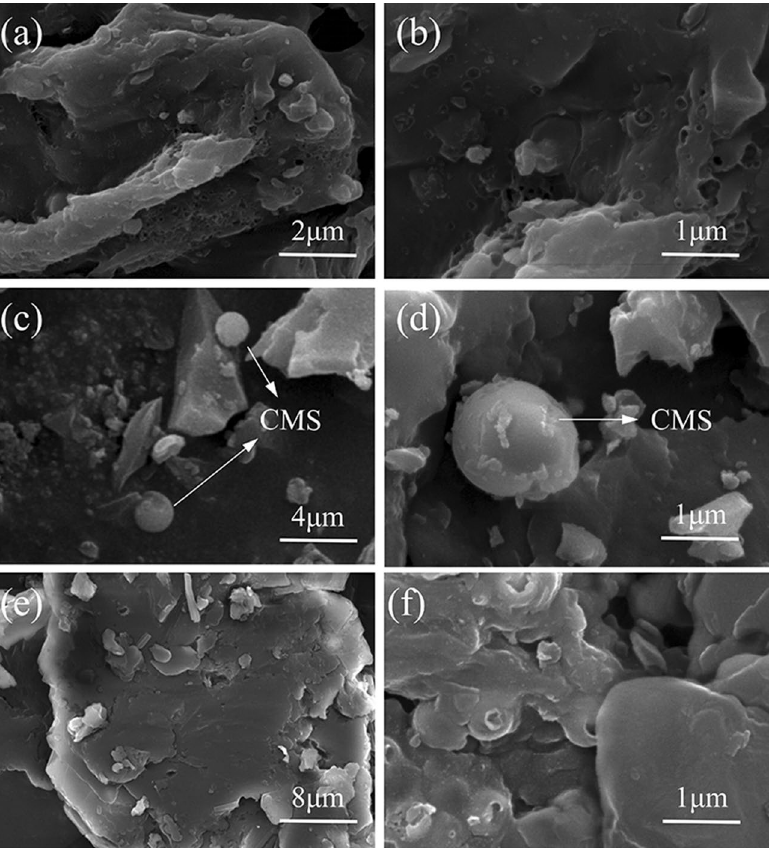
Figure 2. SEM images of WBB ( a , b ), CMS-WBB ( c , d ) and SA/CMS-WBB-2 ( e , f